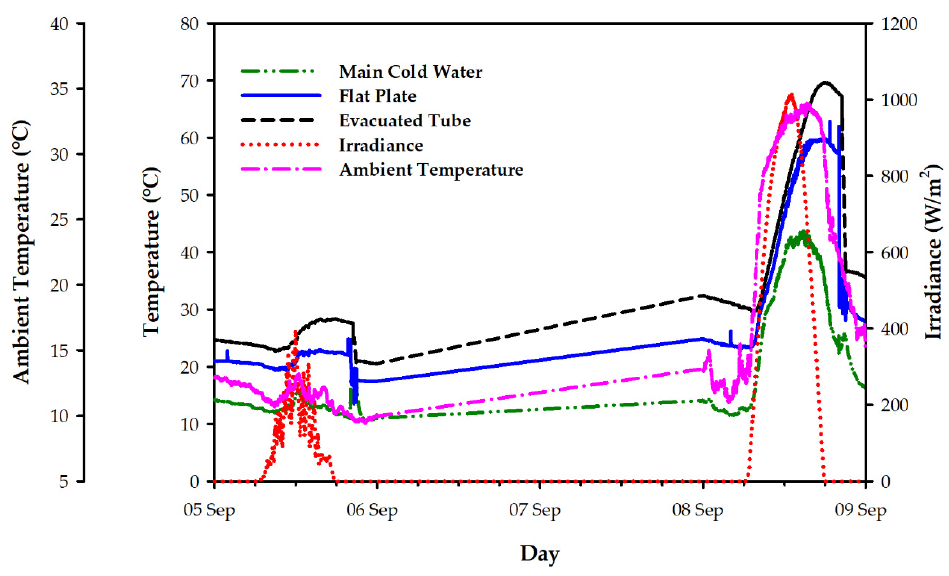
Figure 8. The response of various points on a solar water heating system on a clear and cloudy day.